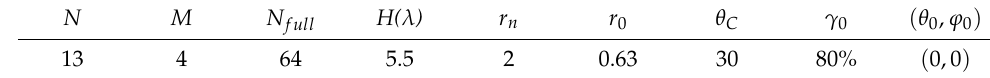
Table 2. The parameters of the example array.